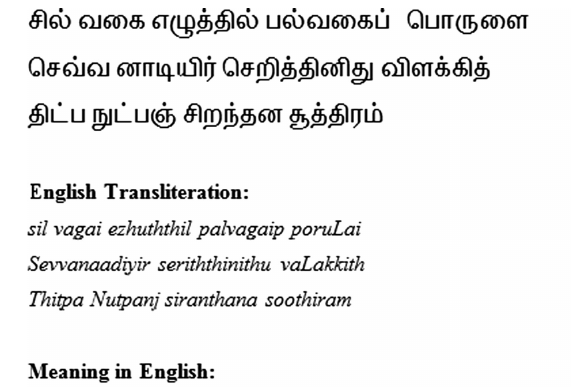
Figure 3. Definition of the Sutra as per Nannool in